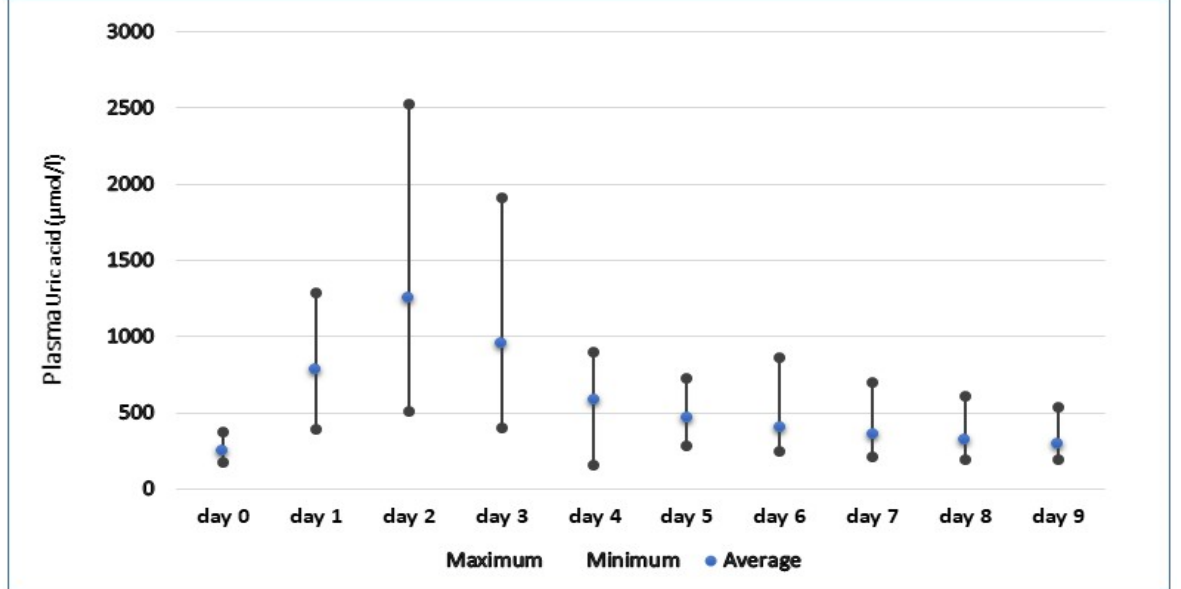
Figure 1. Pre-feeding (day 0) and post-feeding (day 1–9) plasma uric concentration range in snakes after meal 1.